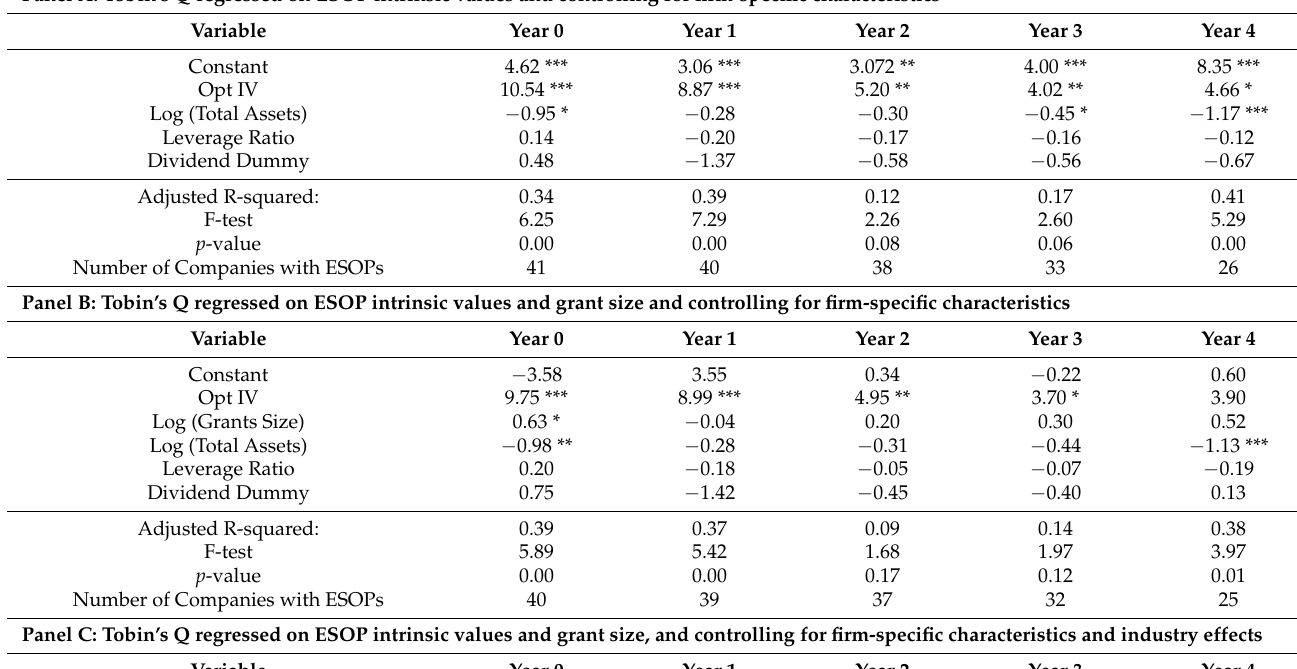
Table 4. ESOPs and value creation. This table reports Tobin’s Q, a proxy for firm performance and Opt IV, which is a proxy for ESOPs intrinsic value and is a ratio of a difference between the market price and the exercise price of ESOPs, over the market price in Panel A. Grant Size is the natural logarithm of option grants owned by executives in Panel B. Panel C depicts the result of Tobin’s Q after controlling for firm-specific characteristics and industry effects. Leverage Ratio is a proxy for firm leverage; Dividend Dummy is a proxy for overinvestment problems, and the natural logarithm of the total assets is a proxy for firm size, as shown in this table. T-statistics are listed under the coefficient of the variables. Industry dummy variables are a proxy for industry effects. The table also describes the adjusted R-square, F-test and p -value at the bottom of the table. Year 0 reflects the year of the first ESOPs issuing; and Year 1 to Year 4 represent the years after issuing. *, ** and *** indicate 90%, 95% and 99% levels of significance,